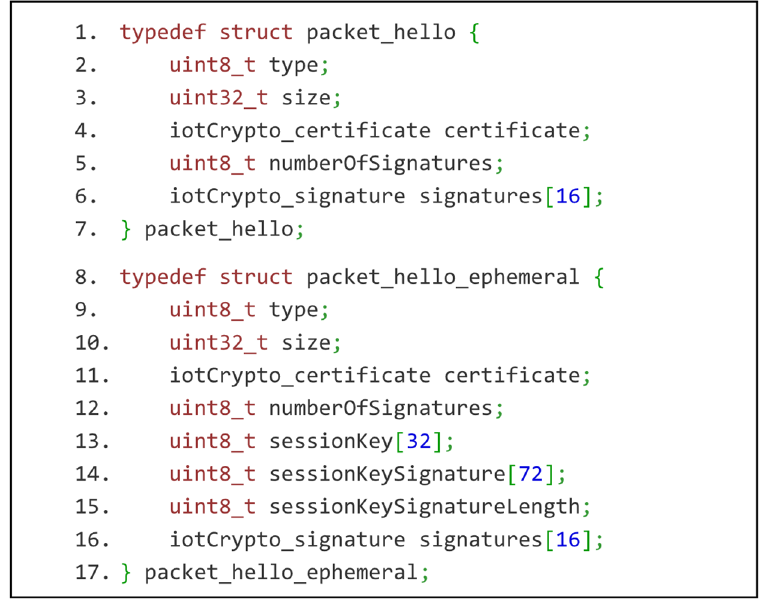
Figure 6. IoT-Connection-Protocol messages presented as C structures.